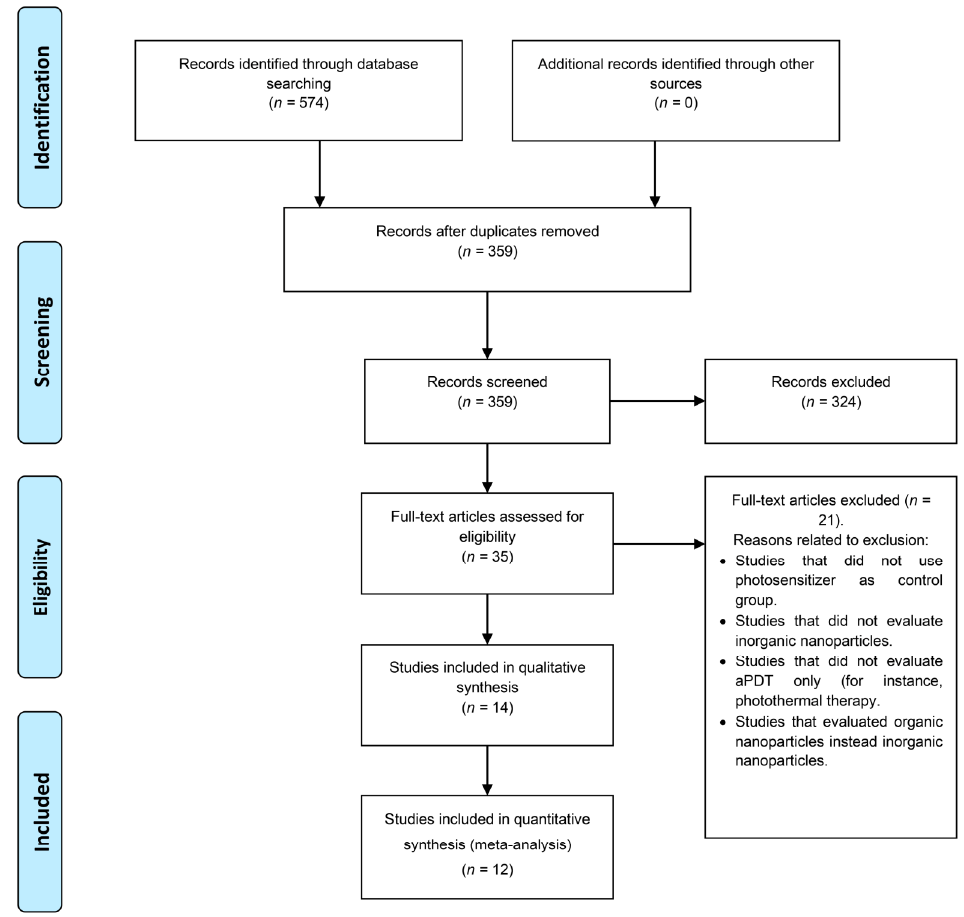
Figure 1. Flowchart based on the PRISMA statement.